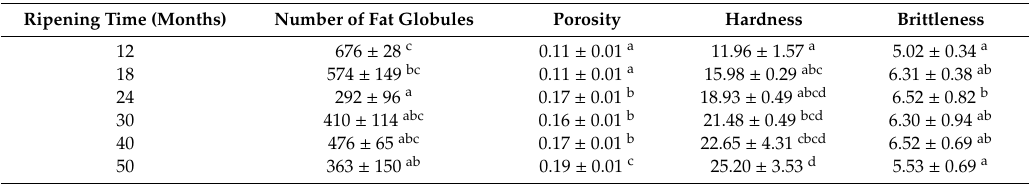
Table 4. Image analysis parameters (number of fat globules and porosity), hardness (N) and brittleness (mm) of Parmigiano Reggiano cheeses ripened from 12 to 50 months.